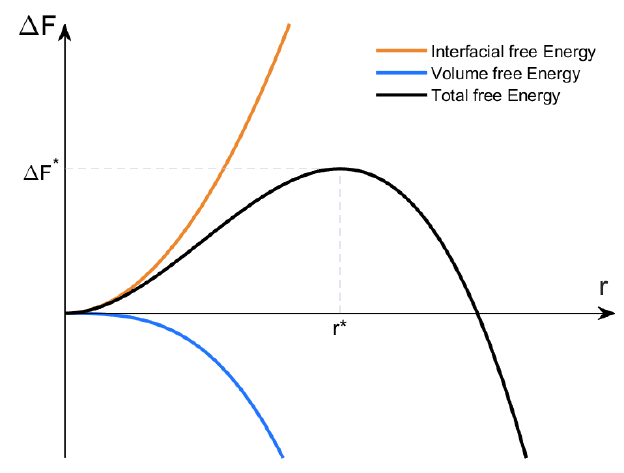
Figure 2. Free energy change vs. cavity radius.